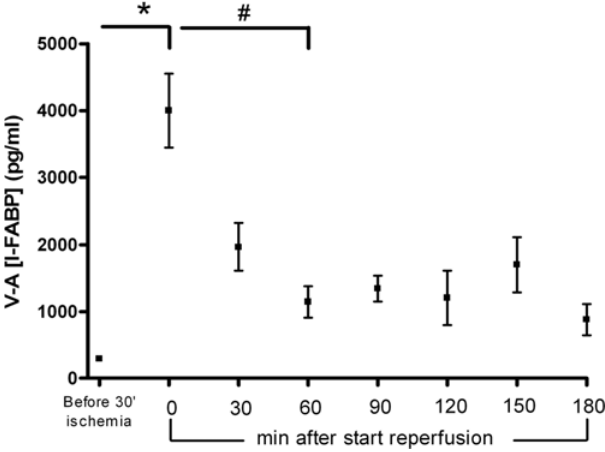
Figure 4. Arteriovenous concentration differences of I-FABP (mesenteric venule minus radial artery), a marker for acute enterocyte damage, across the isolated jejunal segment show rapid significant release of I-FABP after ischemia, while concentration differences of I-FABP gradually reduce following reperfusion. * p , 0.001, # p , 0.001.